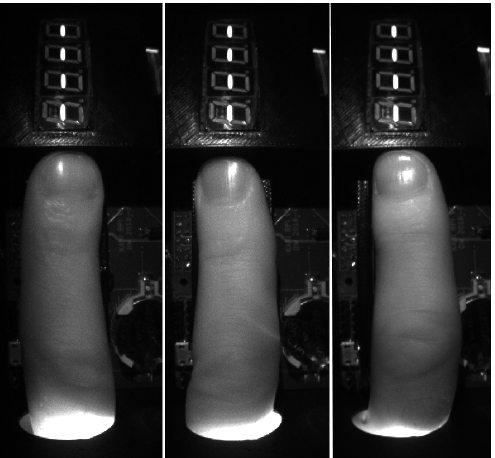
Figure 6. Sample images with front light illumination on (three